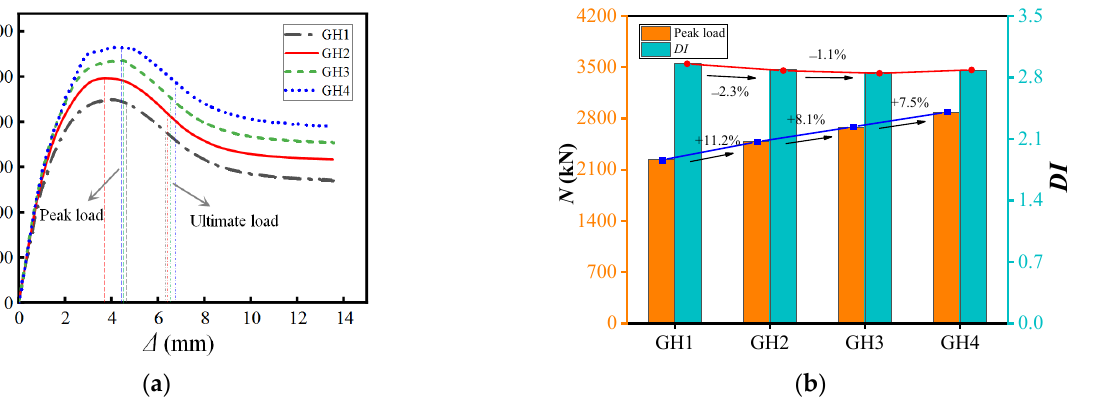
Figure 14. Different width–thickness ratio of steel pipe. ( a ) Load–displacement curve ( b ) Performance Changes